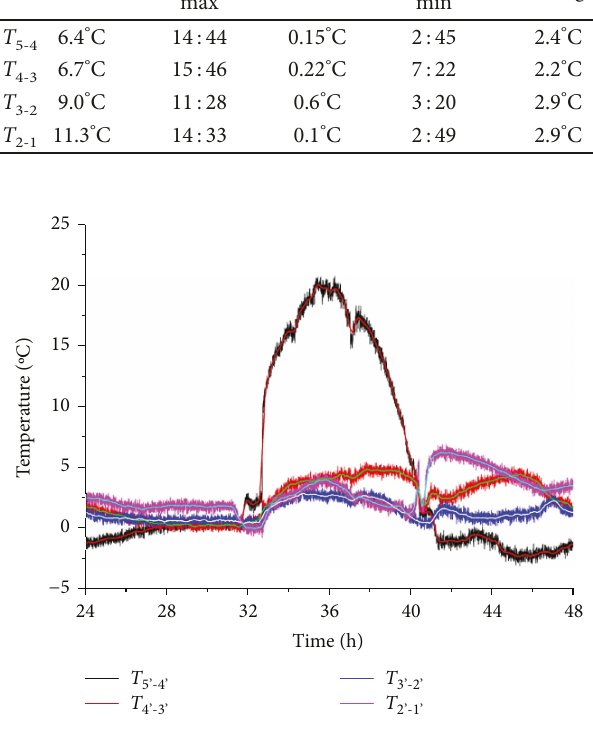
Figure 12: Temperature di ff erence between the nodes of the interior air channel.